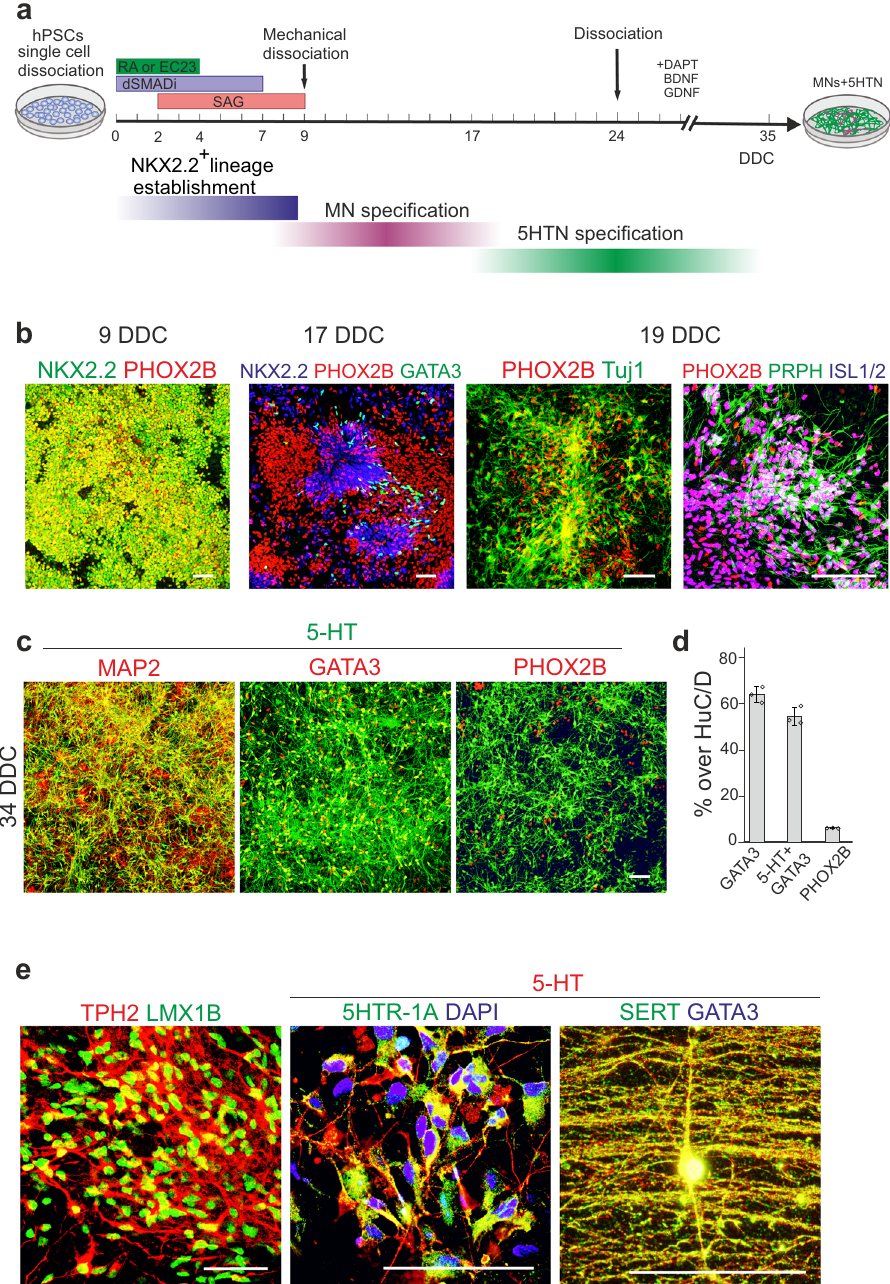
Fig. 6 Speci fi cation of cranial MNs and 5HTNs. a Schematic summary of differentiation conditions and processes timeline during MN and 5HTN generation. b Immunocytochemistry of NKX2.2, PHOX2B, and GATA3 at 9 and 17 DDC, and of Tuj1, PRPH, PHOX2B, and ISL1/2 at 19 DDC in cultures treated with RA 4D + SAG. c Immunocytochemistry for serotonin (5-HT) together with MAP2, GATA3, or PHOX2B at 34 DDC. d Quanti fi cation of HuC/D + cells expressing PHOX2B, GATA3, or GATA3 and 5-HT, at 34 DDC ( n = 3 independent differentiations). Data represented as mean ± S.D. e Immunocytochemistry of indicated markers in 5HTNs at 35-45 DDC. Scale bars: 100 µ m in panels ( b , c ) and 50 µ m in panel ( e